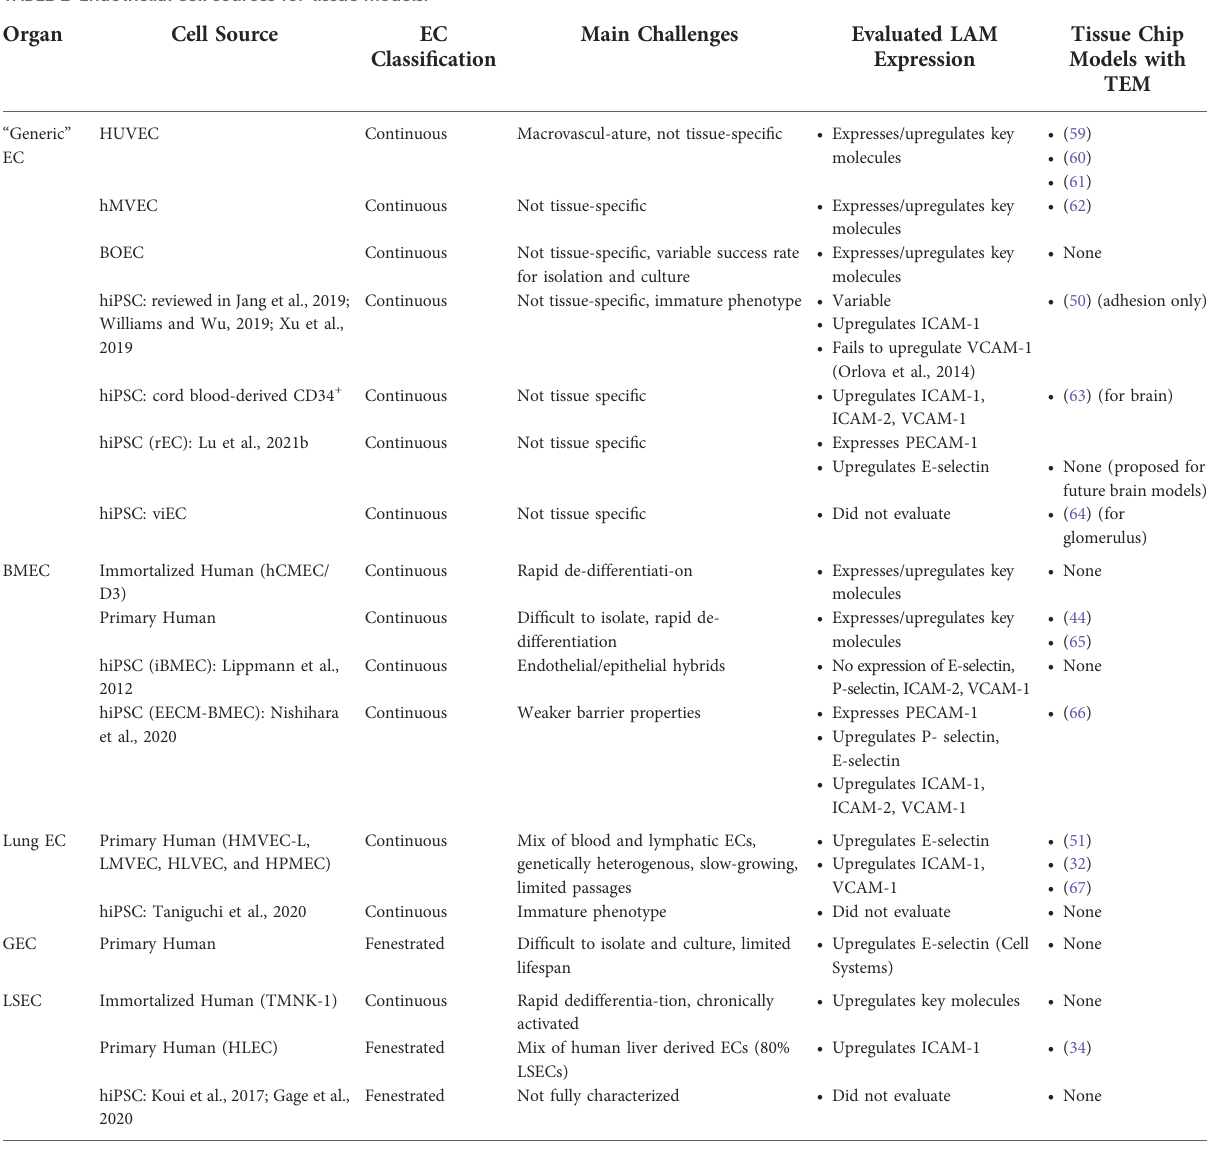
TABLE 2 Endothelial cell sources for tissue